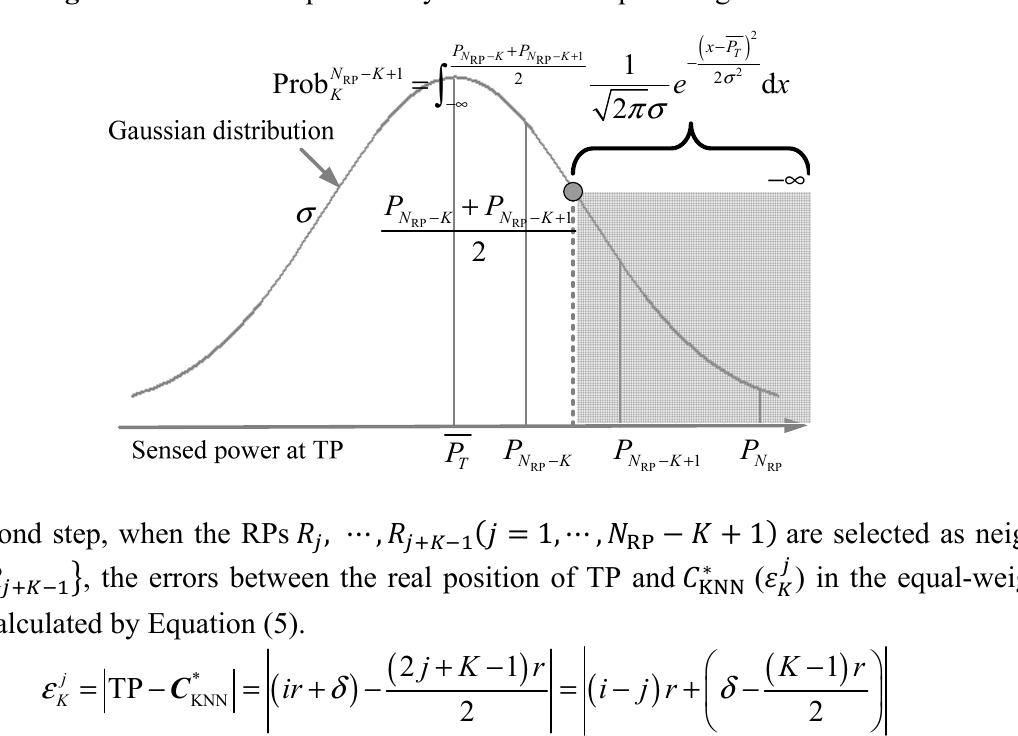
Figure 5. Confidence probability of Case 3 in equal-weighted